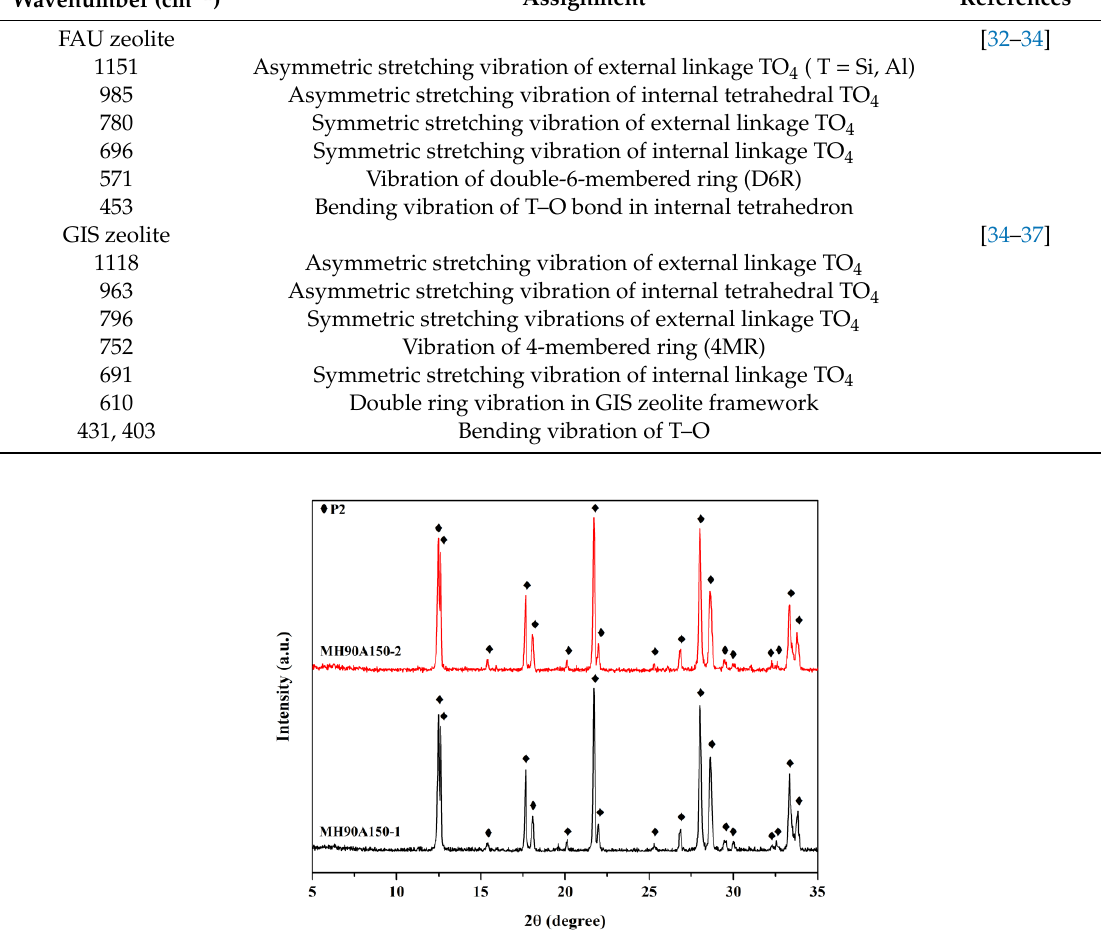
Figure 8. Powder XRD patterns of NaP2 zeolites from microwave-assisted double crystallization for